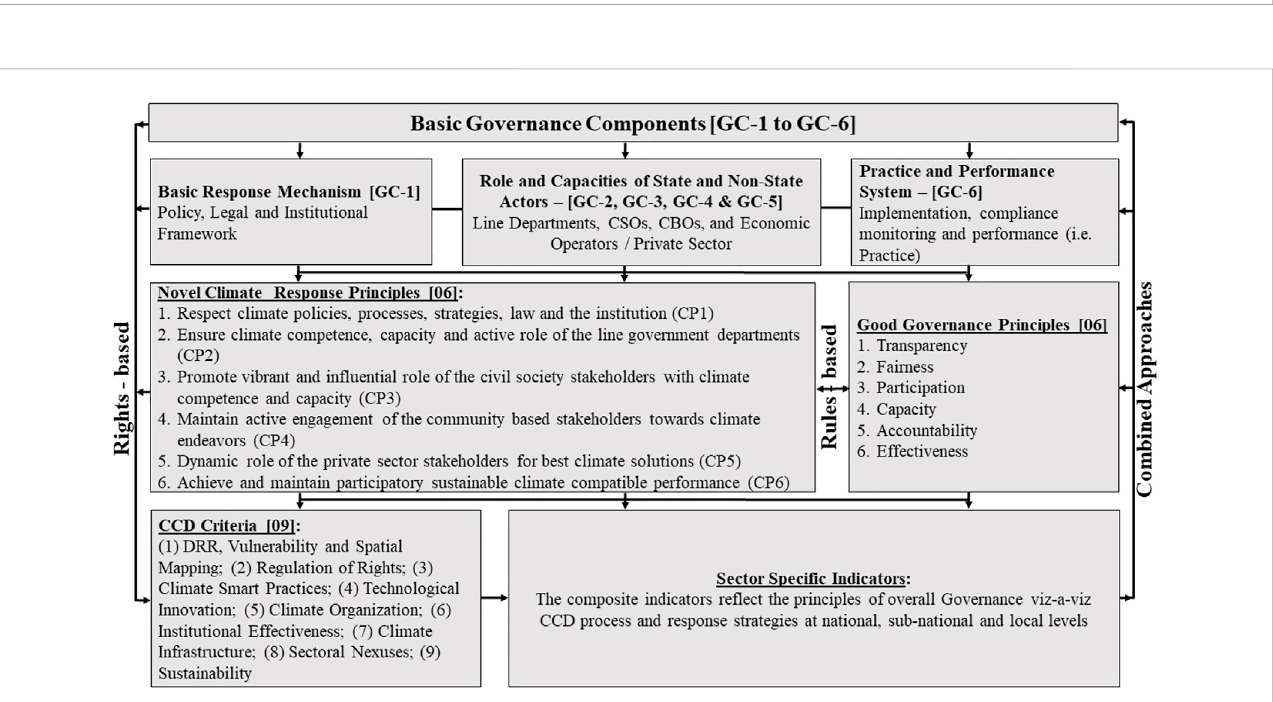
FIGURE 2 Principles, criteria and indicators for CCD assessment model source: (Iqbal, 2021):].